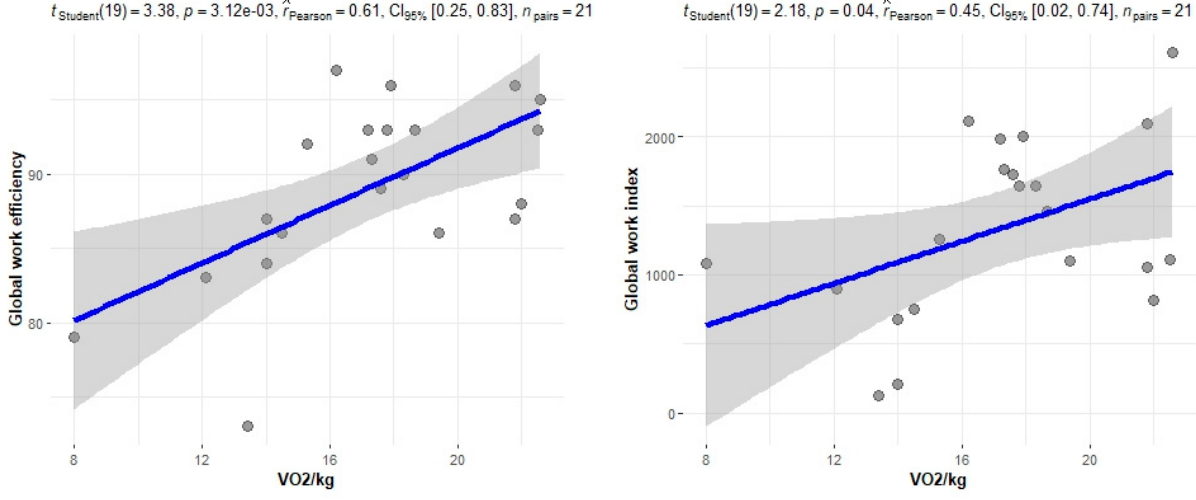
Figure 4. Correlation between CPET parameters and myocardial